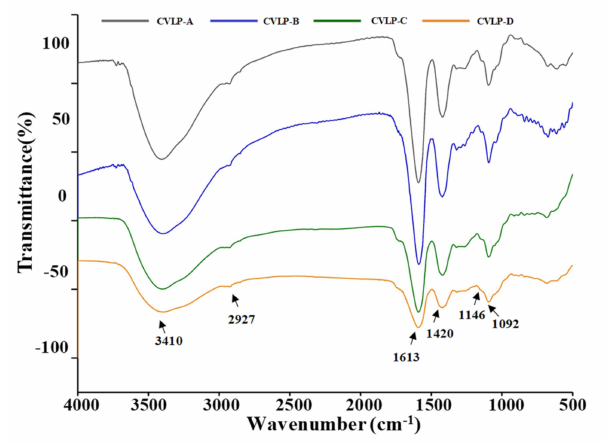
Figure 2. Fourier transform infrared (FT-IR) spectra of CVLPs. CVLP-A , CVLP-B , CVLP-C and CVLP-D , crude polysaccharides extracted from the leaves of C. violaceum collected from Chengdu, Langzhong, Bazhong and Guangyuan,